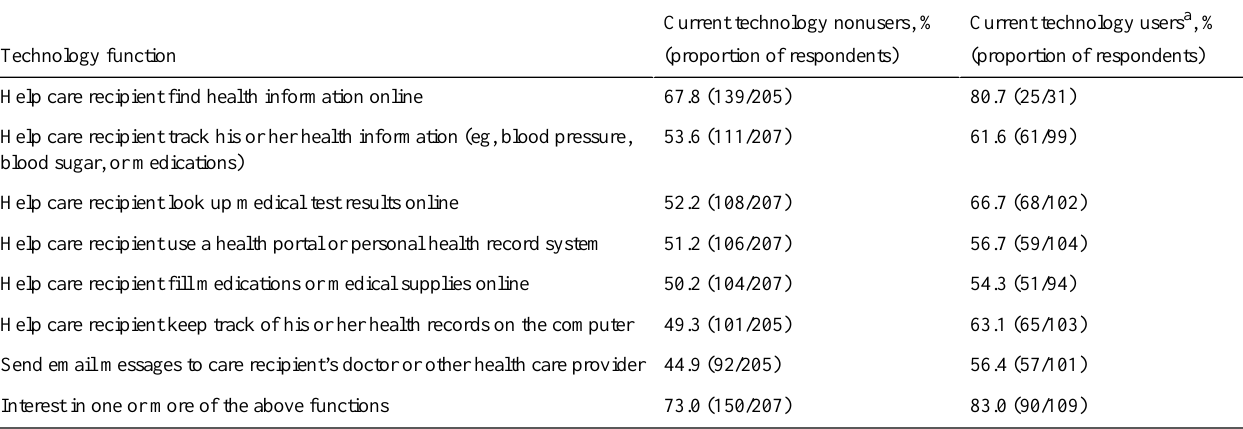
Table 2. Health information technology functions that are of interest to out-of-home caregivers for adults with chronic